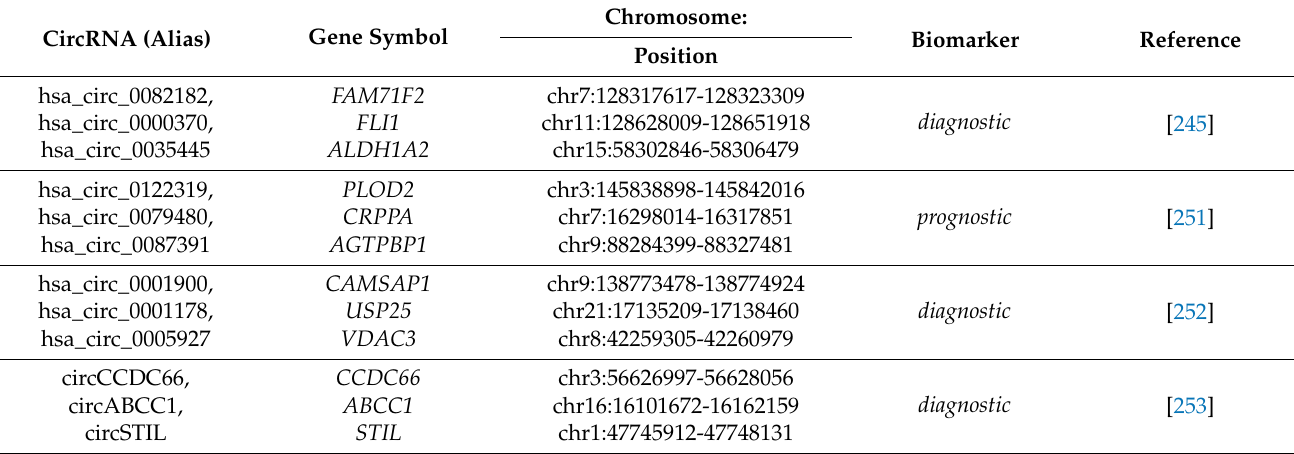
Table 2. Panels of circRNAs with potential for non-invasive biomarkers in CRC